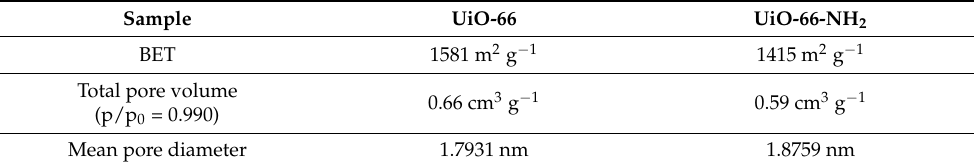
Table 1. BET, total pore volume, and mean pore diameter parameters for MOFs.